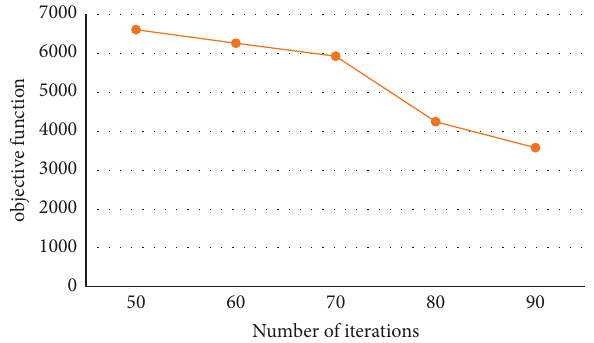
Figure 7: The amount of change in the objective function with an increasing number of iterations of the genetic